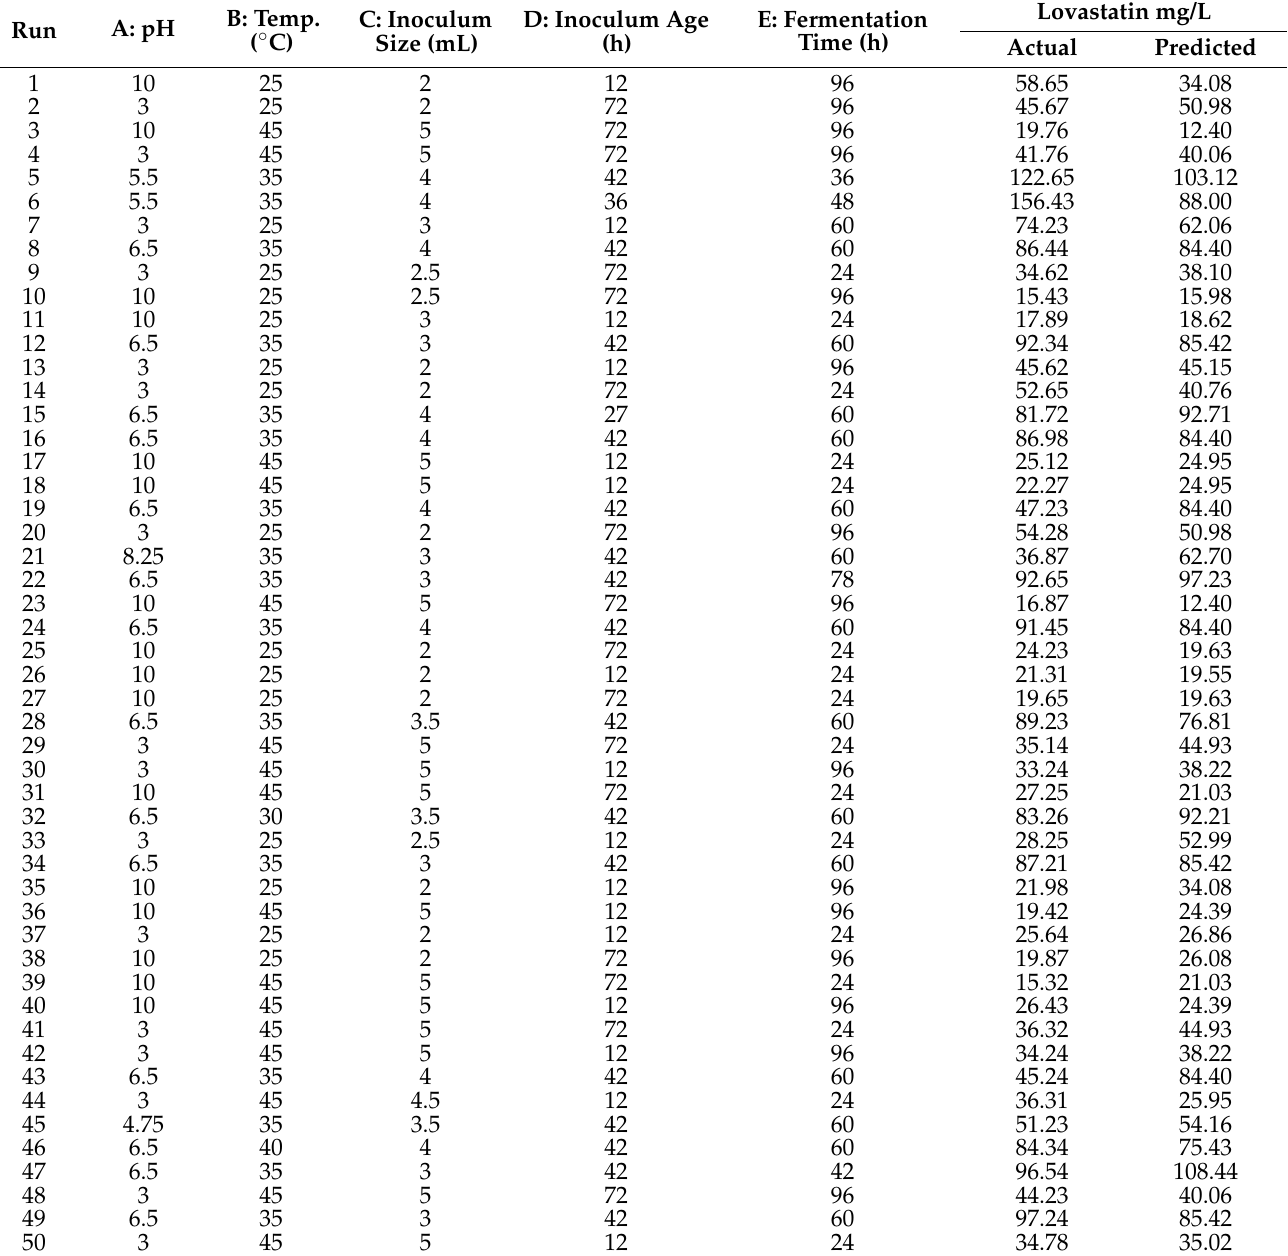
Table 1. Runs report and Central Composite Design (CCD) that compares the predicted and actual response